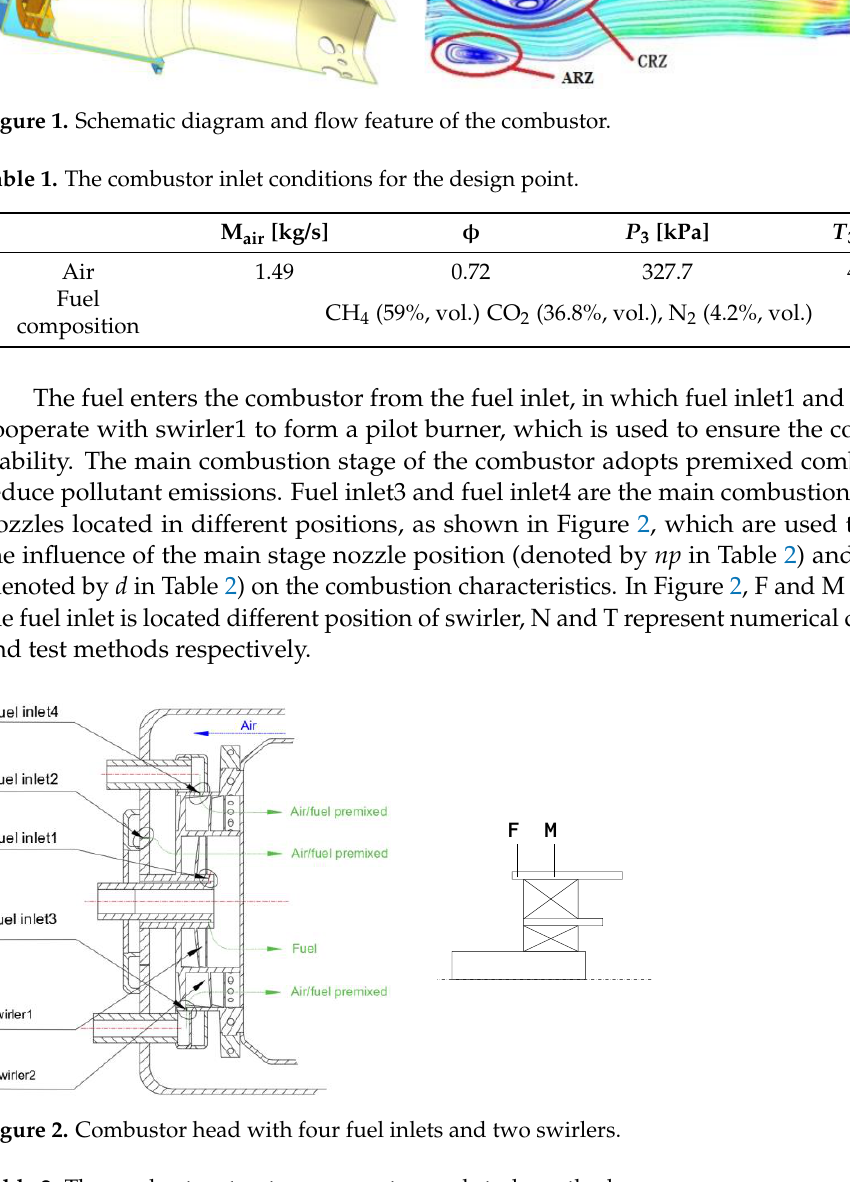
Table 1. The combustor inlet conditions for the design point.